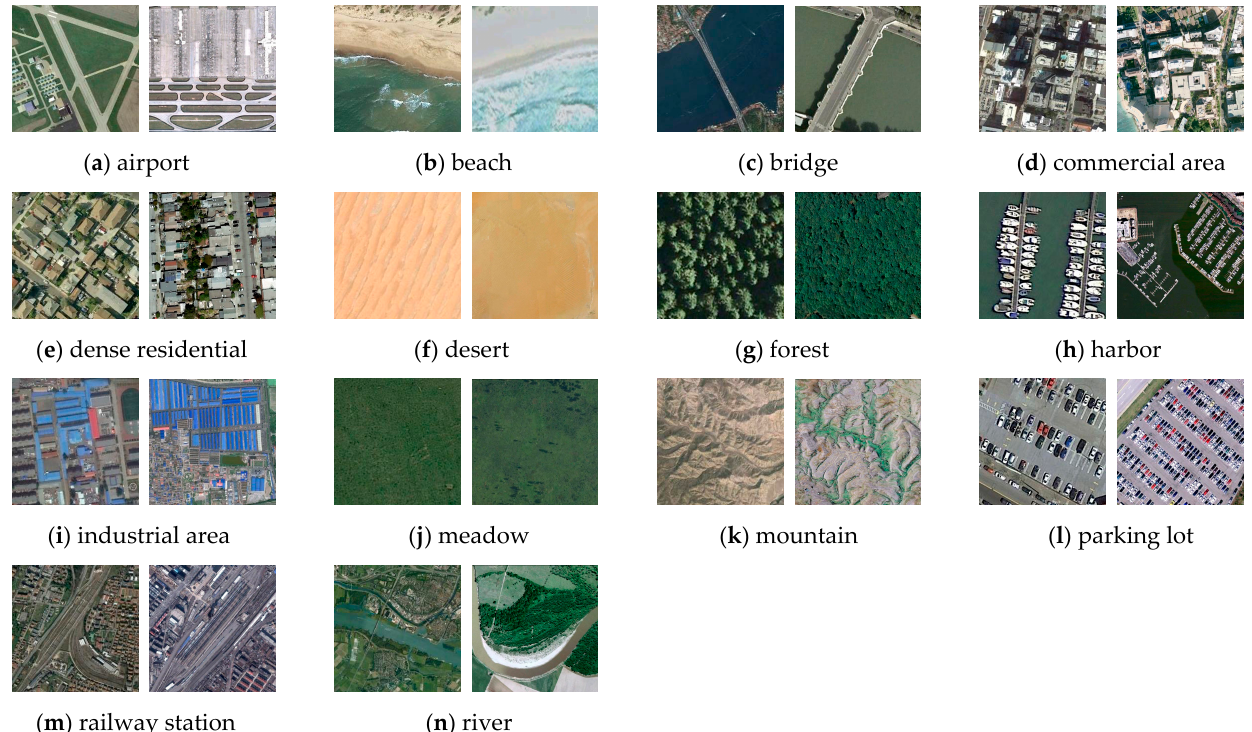
Figure 11. Samples of each common class for NWPU ( left ) and WHU ( right ).